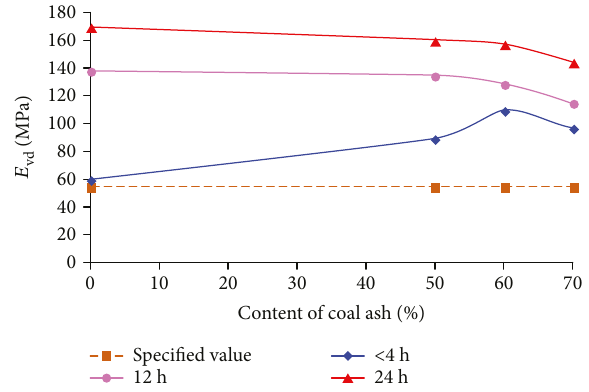
Figure 2: Relation diagram between dynamic deformation modulus E vd and the content of coal ash.